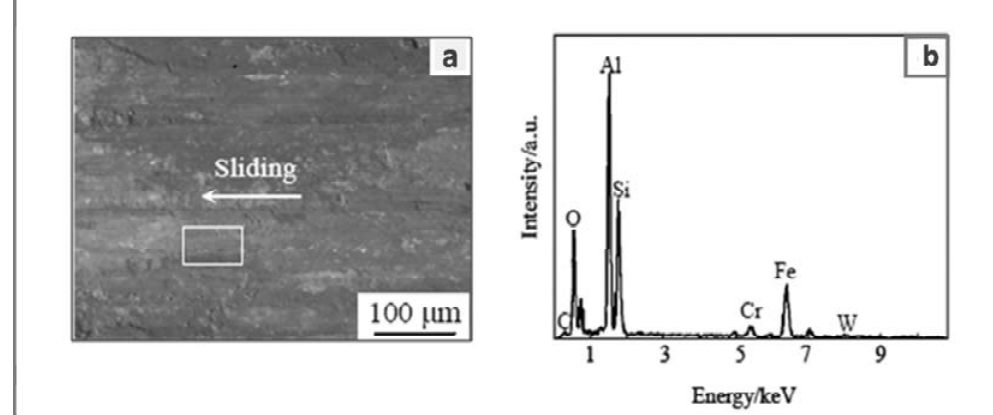
Fig. 6. (a) Optical micrographs of worn surface and (b) EDS analysis of the tribo-layer on the top surface (the area of rectangle in 6.a) of Al/SiC/Gr (20  m) hybrid composite, adapted from